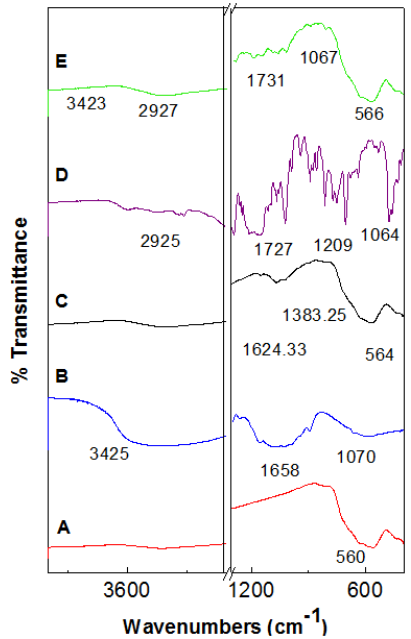
Figure 2. FTIR spectra of ( A ) iron oxide nanoparticles; ( B ) chitosan; ( C ) iron oxide nanoparticles coated with chitosan (FC); ( D ) prindopril erbumine (PE) and ( E ) iron oxide nanoparticles coated with chitosan-prindopril erbumine